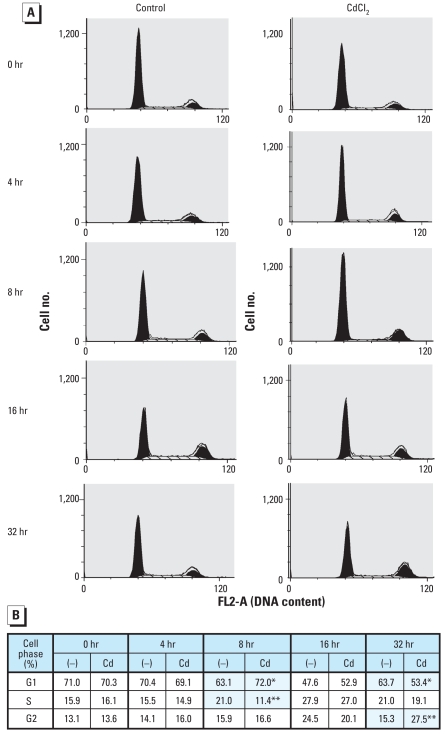
Effect of CdCl2 on cell-cycle distribution in NPrEC cells determined by flow cytometry analysis. (A) Fluorescence analysis of the DNA content. (B) Cd-induced change of the cell phase. The sub-G1 peak, an indication of apoptosis, is not shown. Fluorescence-2 area (FL2-A) is a measure of integrated cell fluorescence signal that represents the DNA content. Data represent results from two replicates.*p < 0.05. **p < 0.01.